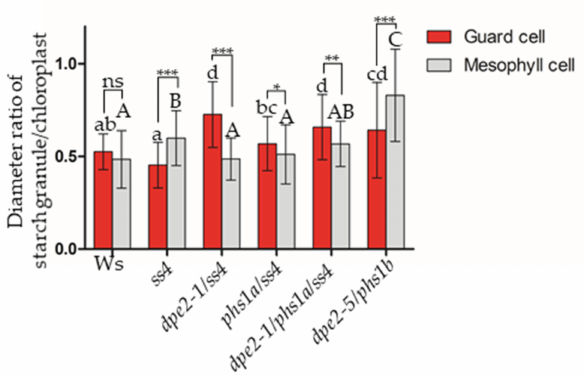
Figure 3. Relative size ratio of the individual starch granules and chloroplasts. The ratios of the starch granule sizes and chloroplast sizes in the guard and mesophyll cells are provided. The mean and SD calculated from 50 values are shown. Upper- and lowercase letters indicate the statistically significant differences ( p ≤ 0.05) among the mesophyll and guard cells, respectively, according to the one-way ANOVA with Tukey’s post-hoc test. Asterisks show the significant differences between the mesophyll and guard cells within the same lines: ns, no significance; * p < 0.05, ** p < 0.01 and *** p < 0.001, based on t